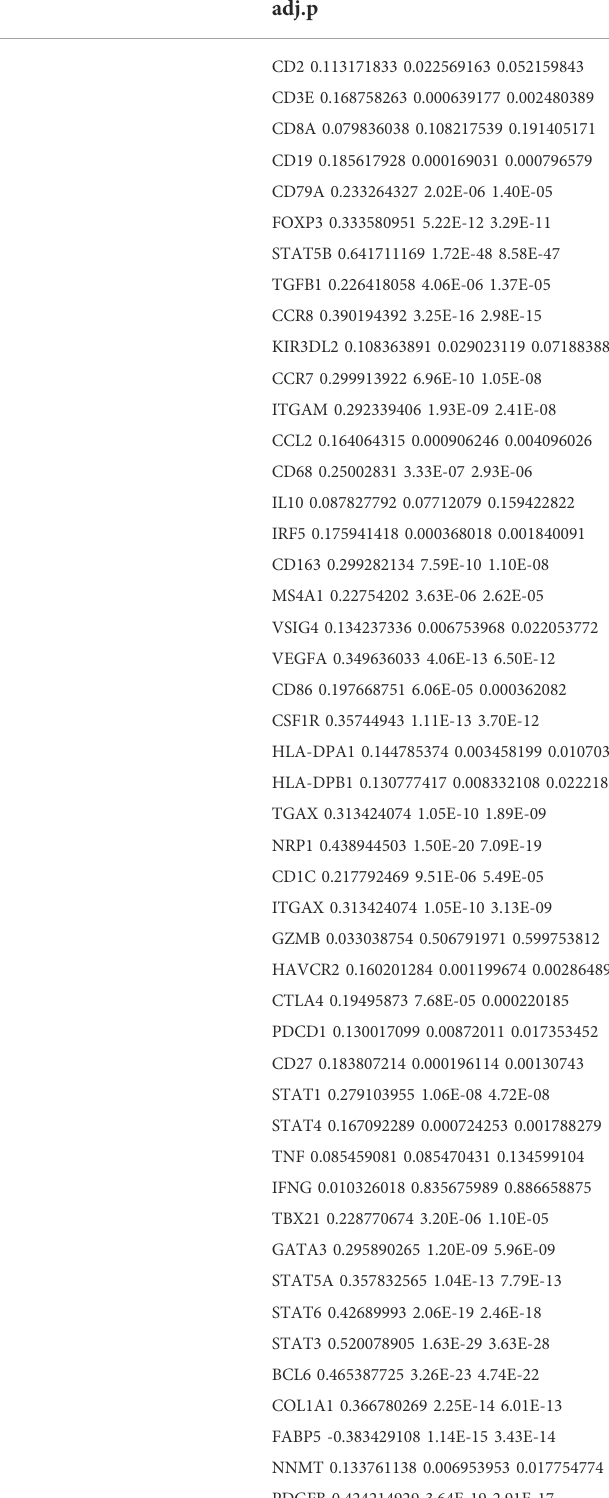
TABLE 3 Correlation between ARID1B and immune cell biomarkers in